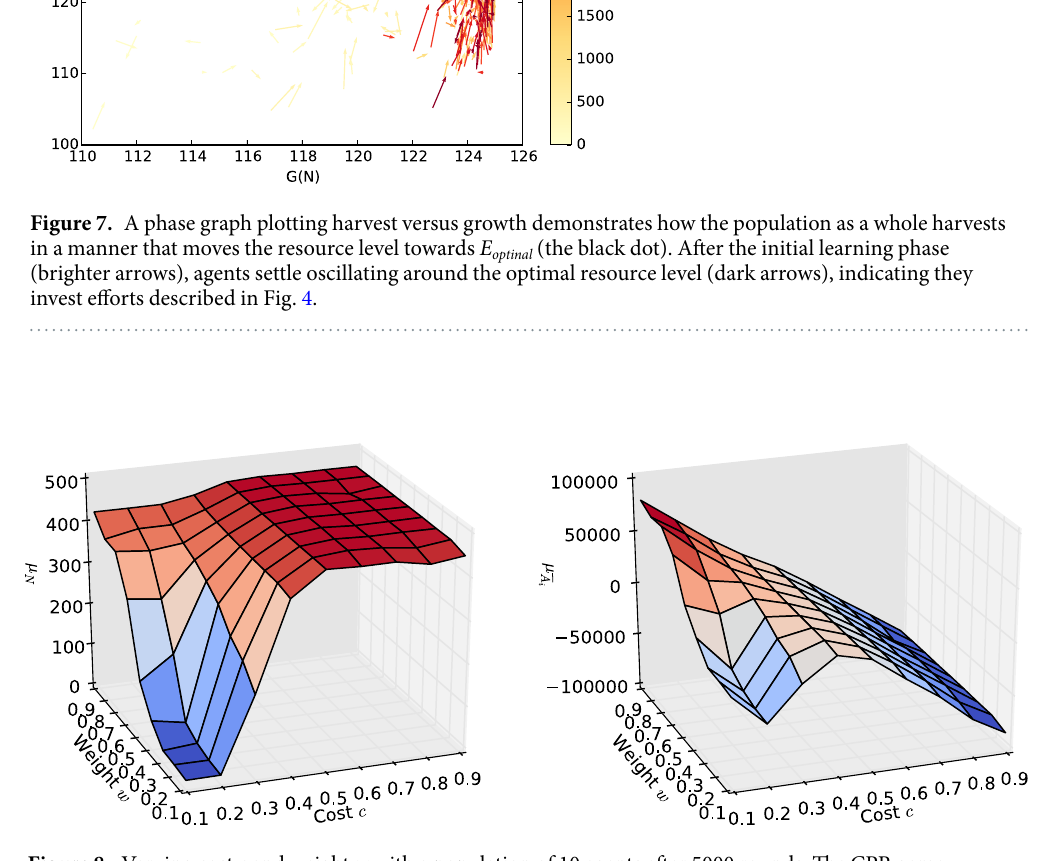
with outcomes that are gains relative to their reference point—they choose sure smaller gains over larger riskier gains—but become risk seeking when dealing with losses 79 . This is in contrast to the widely accepted economic perspective, where a rational decision-maker is an individual who attempts to maximise their expected utility in any decision-making scenario. In the case of Reinforcement Learning applied to the CPRG, the risk decreases with a lower cost and higher investments become less risky, as the expected reward becomes positive even for high investments. Thus the profit component of the Reinforcement Learning reward signal R is more dominant and steers the behaviour of agents towards greediness. Figure 8 indicates that agents can discount their global goal of sustainability to a rather surprising extent, unless the cost parameter makes it difficult to distinguish profitable and sustainable harvesting efforts. The reason for this seems to lie in the fact that considering profit explicitly actually teaches an agent that sustainability has a significant influence on how profitable harvests are in the long run. If agents solely consider their profits for harvesting decisions they fail to harvest sustainably nor profitably, as no distinction between sustainability and profitability takes place. This result indicates that sustainability is related to cost. When the cost is too high, almost all actions an agent takes lead to a loss. Thus the sustainability component of the Reinforcement Learning reward signal R becomes the dominant factor, steering agents towards sustainability. Only in situations with a reason- ably low cost allowing profits to be made, sustainability is proportional to the weight placed on it. In the overall